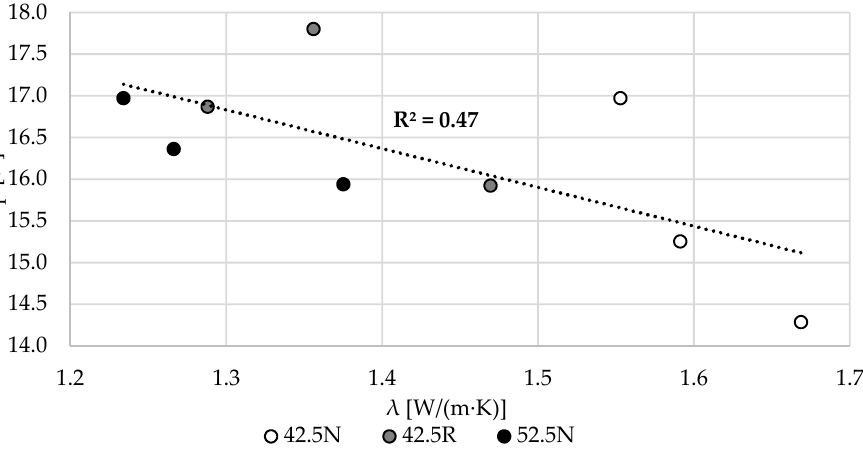
Figure 13. The relation between the thermal conductivity, λ , and total porosity, p (MIP).